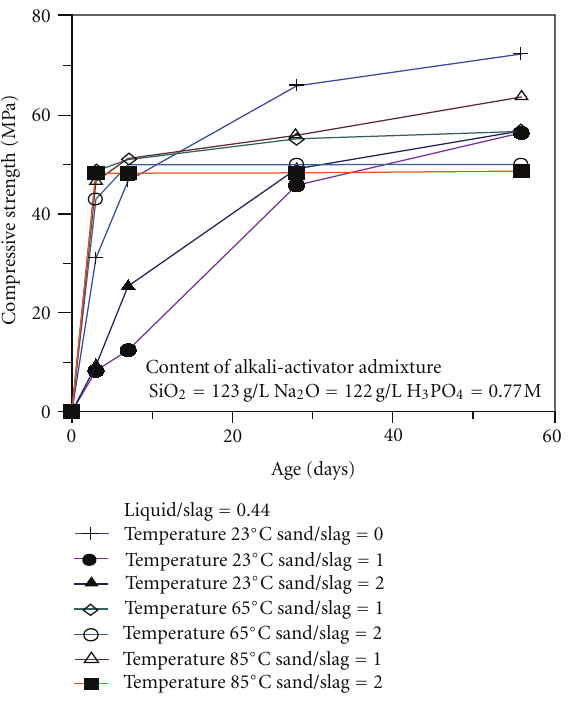
Figure 2: Compressive strength of AAS mortars ( L/S = 0 . 54).